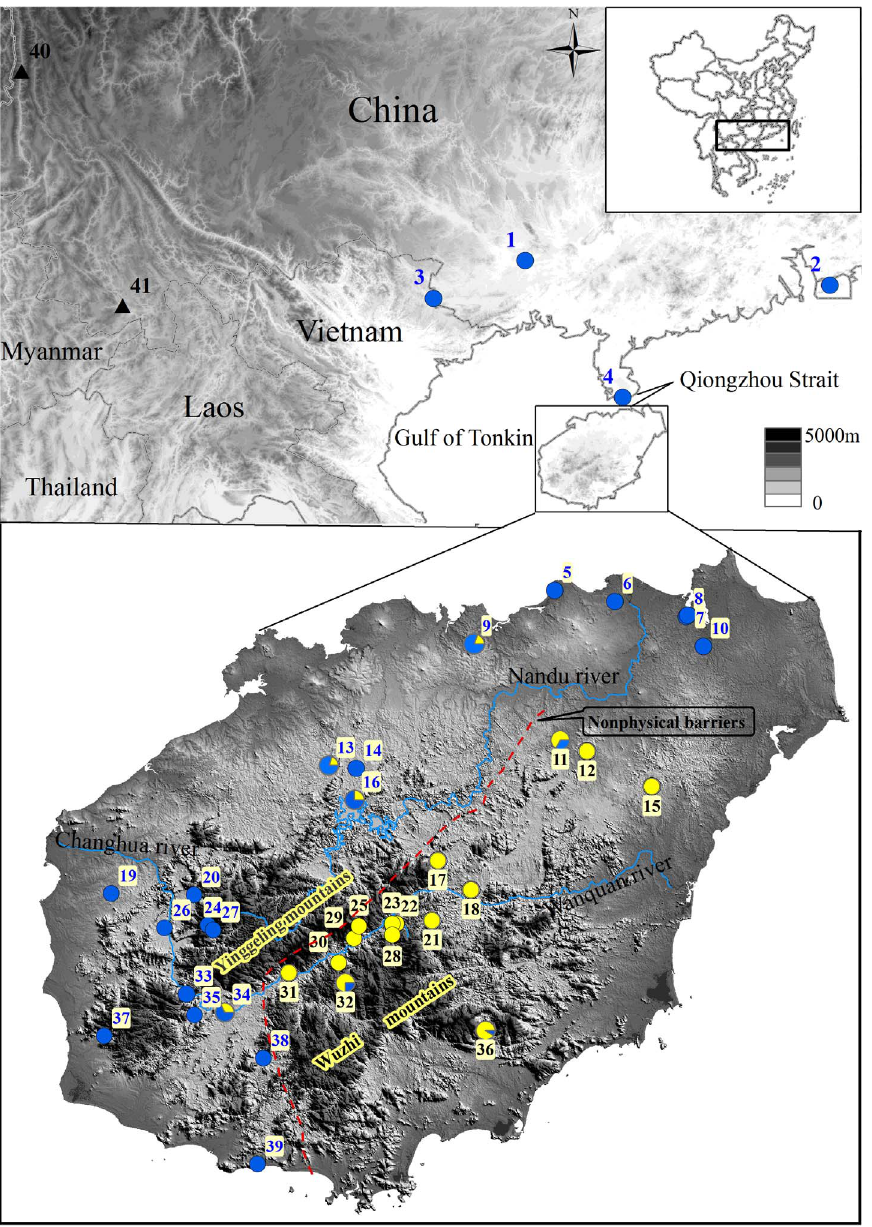
Figure 1. Sampling localities of Calotesversicolor on Hainan Island and the mainland. Samples are numbered following Table 1. Yellow and blue circles represent lineage A haplotypes and lineage B haplotypes, respectively. The sampled C. versicolor -like population of Yunnan is indicated by the black triangle. Populations with mixed haplotypes are represented by pie charts indicating the proportion of each haplotype. The approximate position of the non-physical barrier is shown.